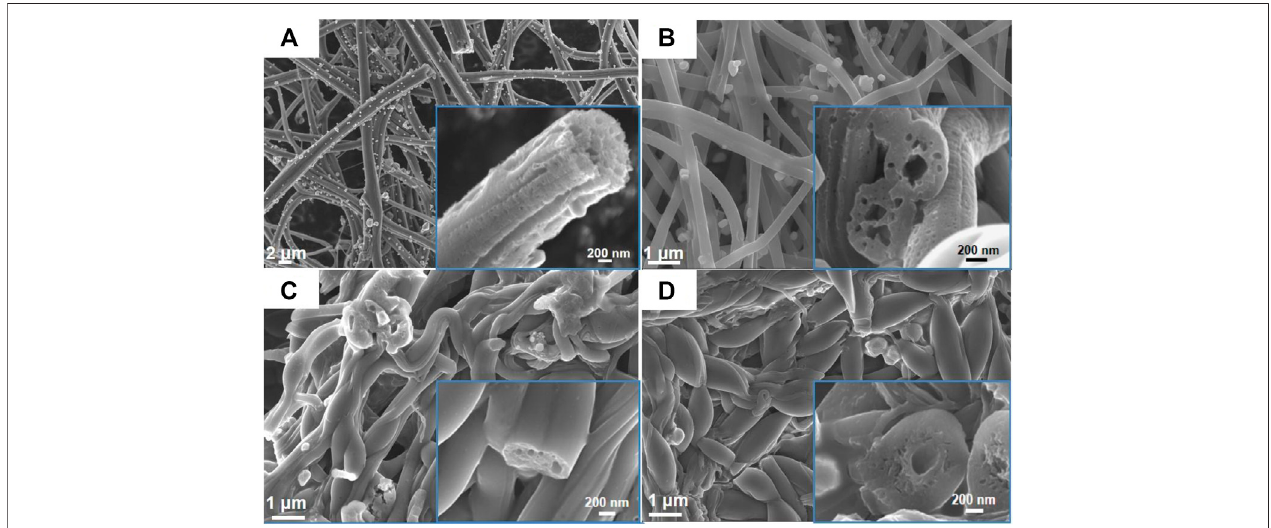
FIGURE 5 | Elemental mapping and distribution of (A) 2FeS2@CNFs, (B) 3FeS2@CNFs, (C) 4FeS2@CNFs, and (D) 5FeS2@CNFs.